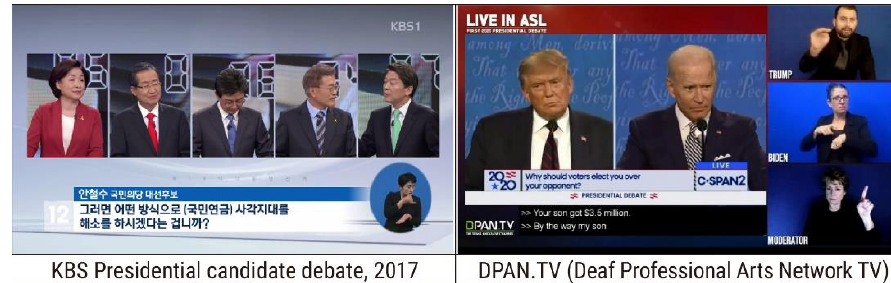
Figure 6. Example of sign language services in discussion.